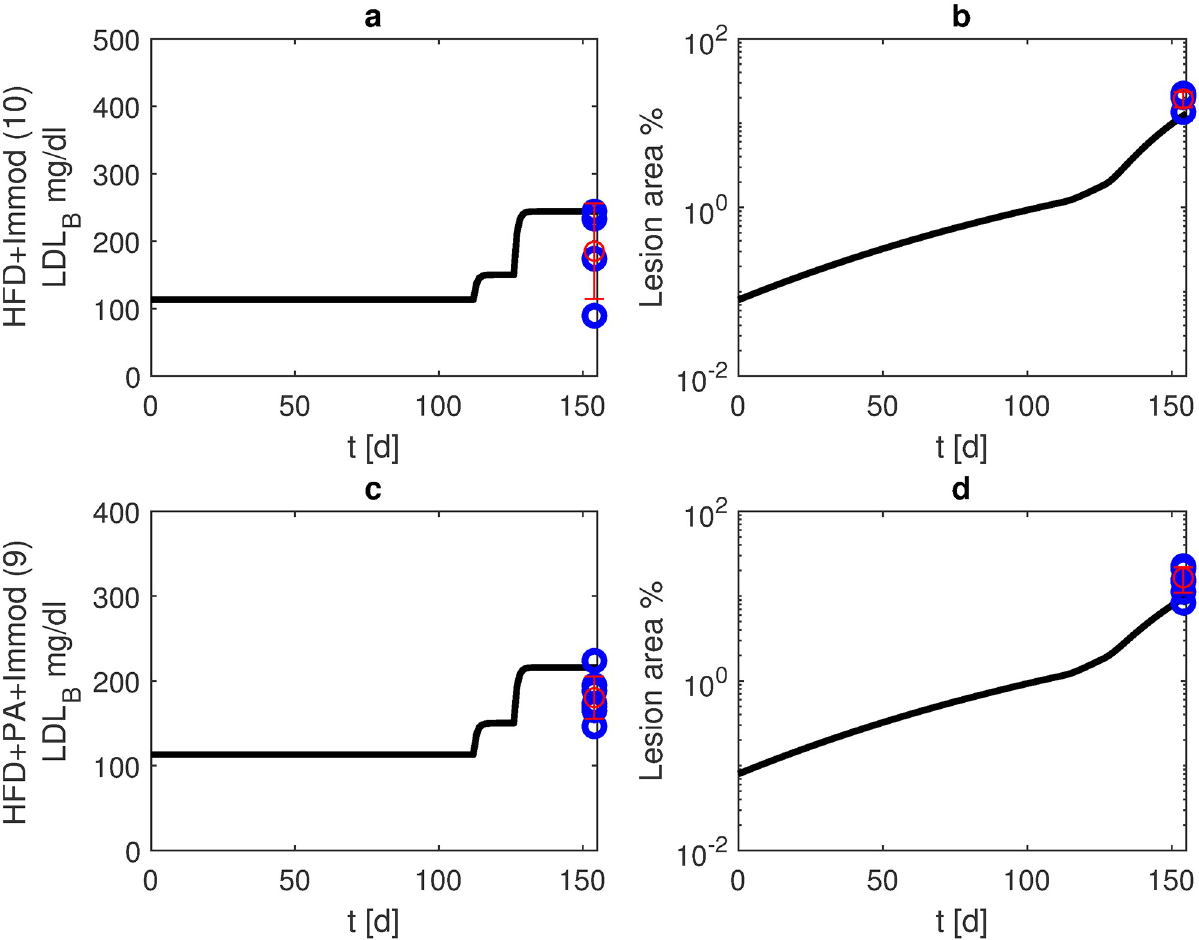
Fig 9. Immune modulating therapy and HFD with or without PA treatment. We present model simulations and data of APOE -/- mice under HFD starting at the age of 16 weeks and IL-10 blockage starting at the age of 18 weeks until the end of observation period (blue: data points, red: mean and standard deviation for scenarios 10 (without PA, panels a, b) and 9 (with PA from week 18, panels c, d). Black curves represent model simulations of LDL-C in blood (panels a, c) and lesion area (panels, b, d).